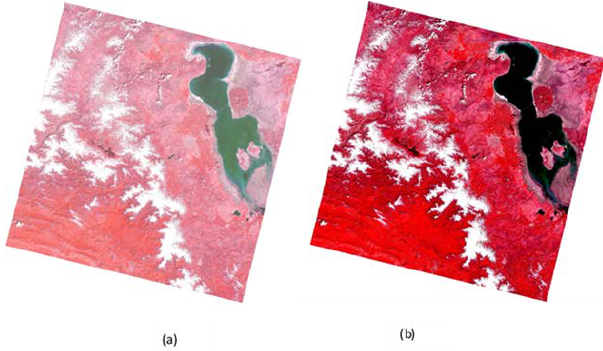
Figure 2. Atmospheric correction, a) image before correction, b) image after correction